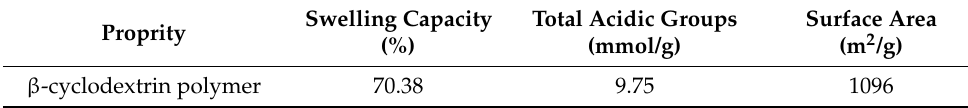
Table 1. Some proprieties of β -cyclodextrin